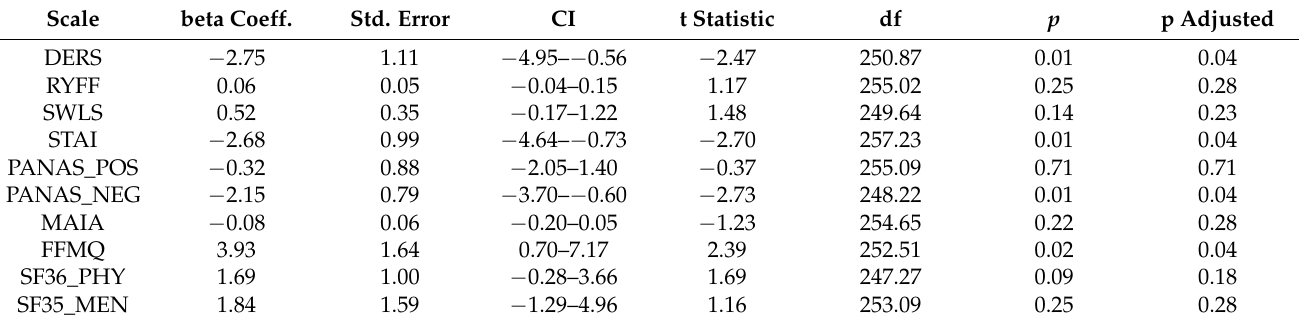
Table 3. Mixed-effects model interaction estimates between Health Behavior, Probiotic intake and time for each